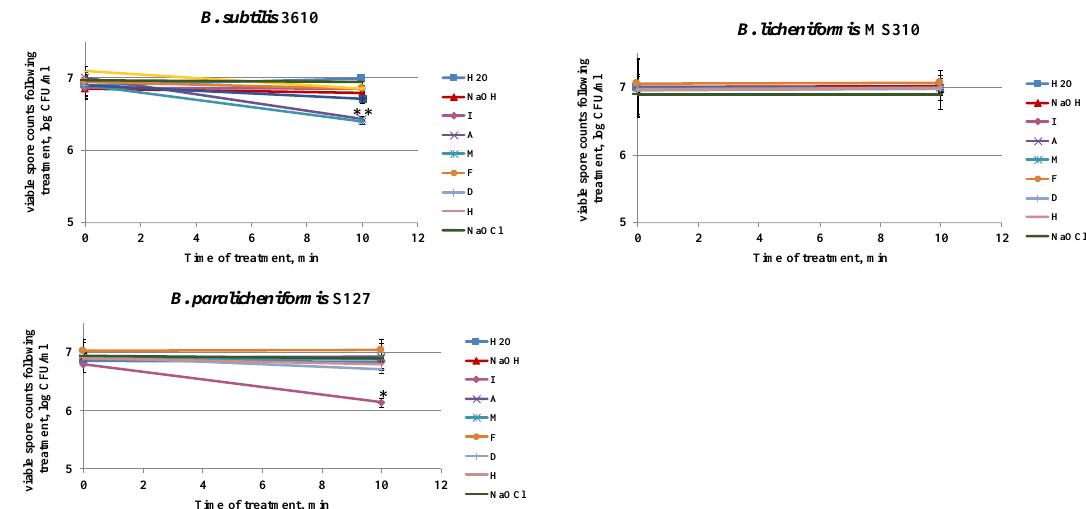
Figure 4. E ff ect of the examined cleaning agents on the viability of the biofilm-derived spores of the tested Bacillus strains. Caustic soda, sodium hypochlorite, and di ff erent cleaning solutions—I, A, M, F, D, and H (compositions are described in Methods)—were added to the tubes, with spore suspension of the tested Bacillus isolates. Spore suspension, without any detergent, was used as the control. The e ff ect on spore viability was evaluated by comparing the numbers of viable spores in the control and after the treatment with the tested agents (following 10 min of incubation at 50 ◦ C, 250 rpm). The results represent the means and standard deviation (SD) of two independent biological experiments, performed in duplicate. * Statistically significant di ff erence ( p < 0.05) between the viable spore counts in a given sample versus the spore counts after cleaning with water